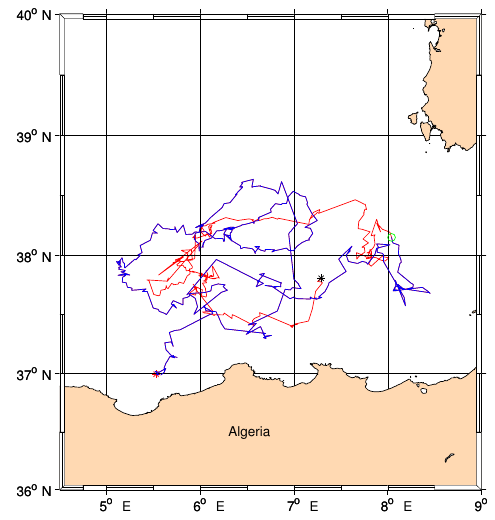
Figure 4. Tracks of the eddy described by Puillat et al. (2002) be- fore and after the application of the eddy continuity routine. The blue line shows the track without running the continuity routine (the red star indicates the formation point), while the red line (star) indi- cates the new part of the trajectory (termination). The green circle shows the junction of the two